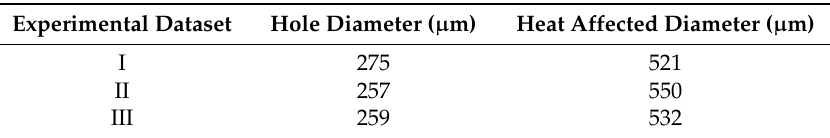
Table 2. Hole diameter and diameter of the heat affected